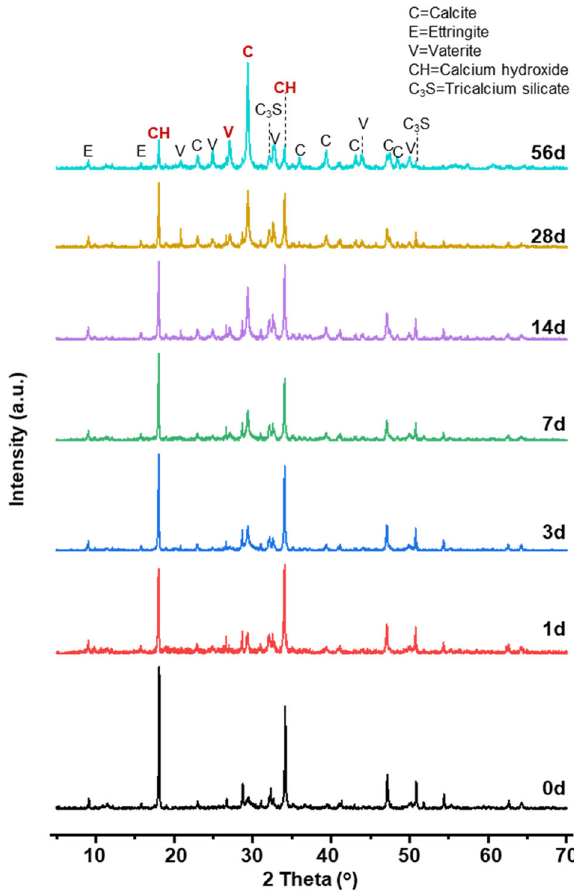
Fig. 7 Characterization of the chemical composition of carbona- tion products. XRD pattern of cement paste specimens after 0d, 1d, 3d, 14d, 28d, and 56d of accelerated carbonation.